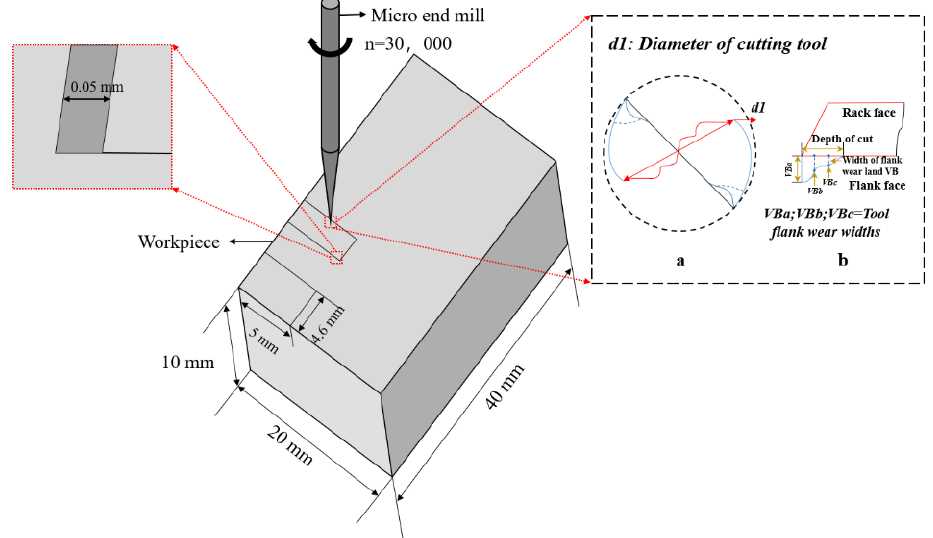
Figure 5. Schematic diagram of experimental scheme and geometrical measurement of wear ( a ) tool diameter reduction analysis and ( b ) wear analysis of rear tool face.